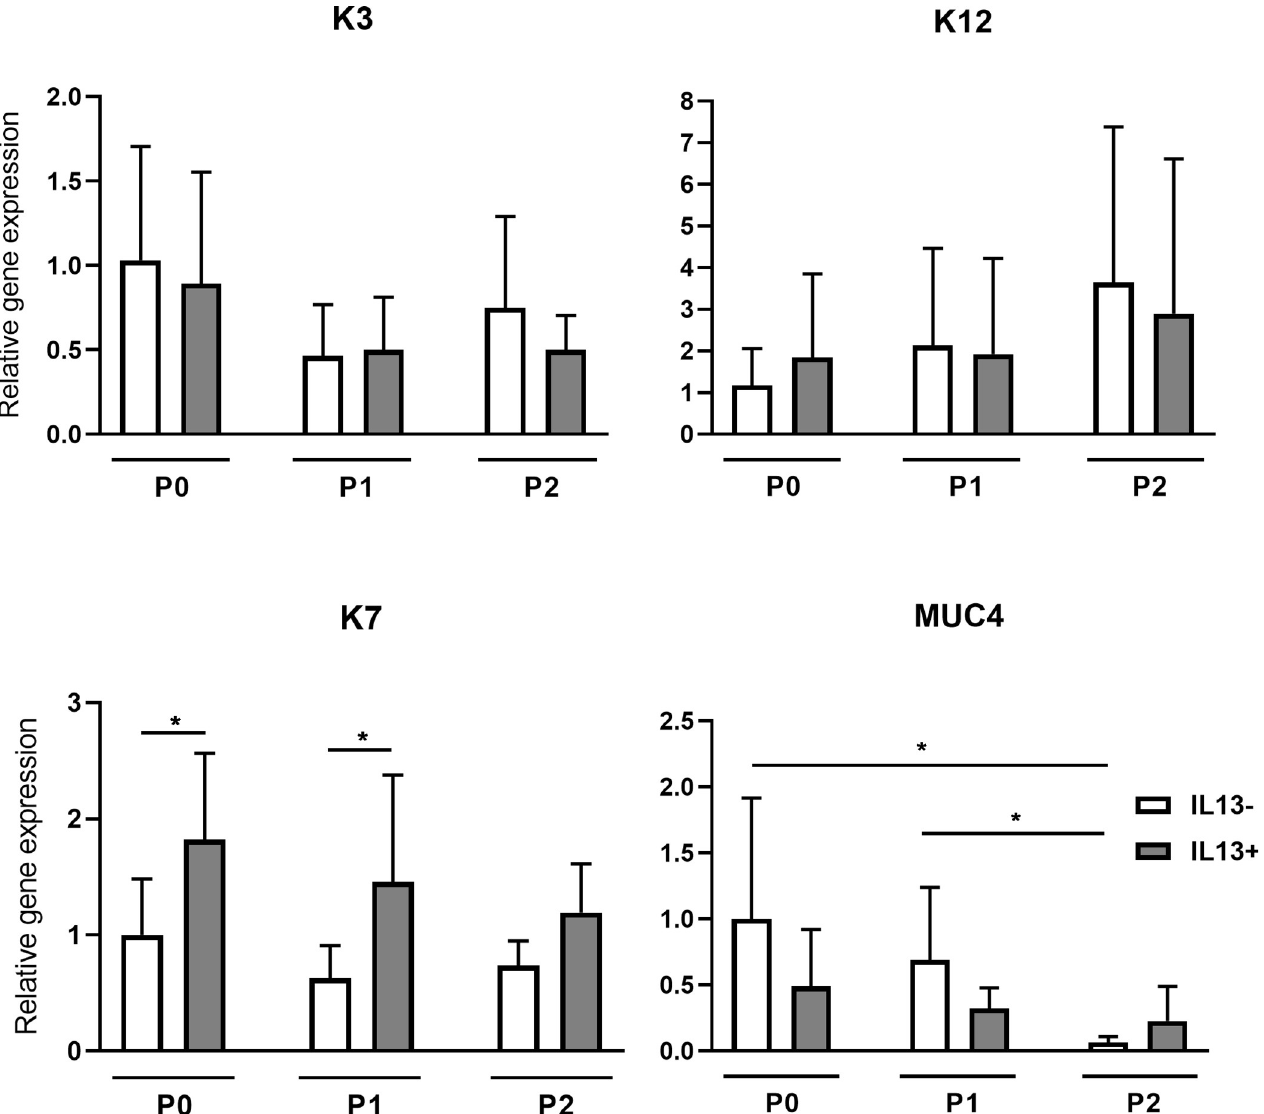
Fig 6. Relative gene expression of K3 , K12 , K7 , and MUC4 in IL13- and IL13+ cell cultures. Cells originating from limbal explants (P0) and passaged cells (P1 and P2) at the end of culture were analyzed for the expression of K3 , K12 , K7 , and MUC4 genes by qPCR. Each bar represents the mean ± SD of four to ten determinations. The asterisks represent a statistically significant difference between the examined groups ( � P < 0.05).